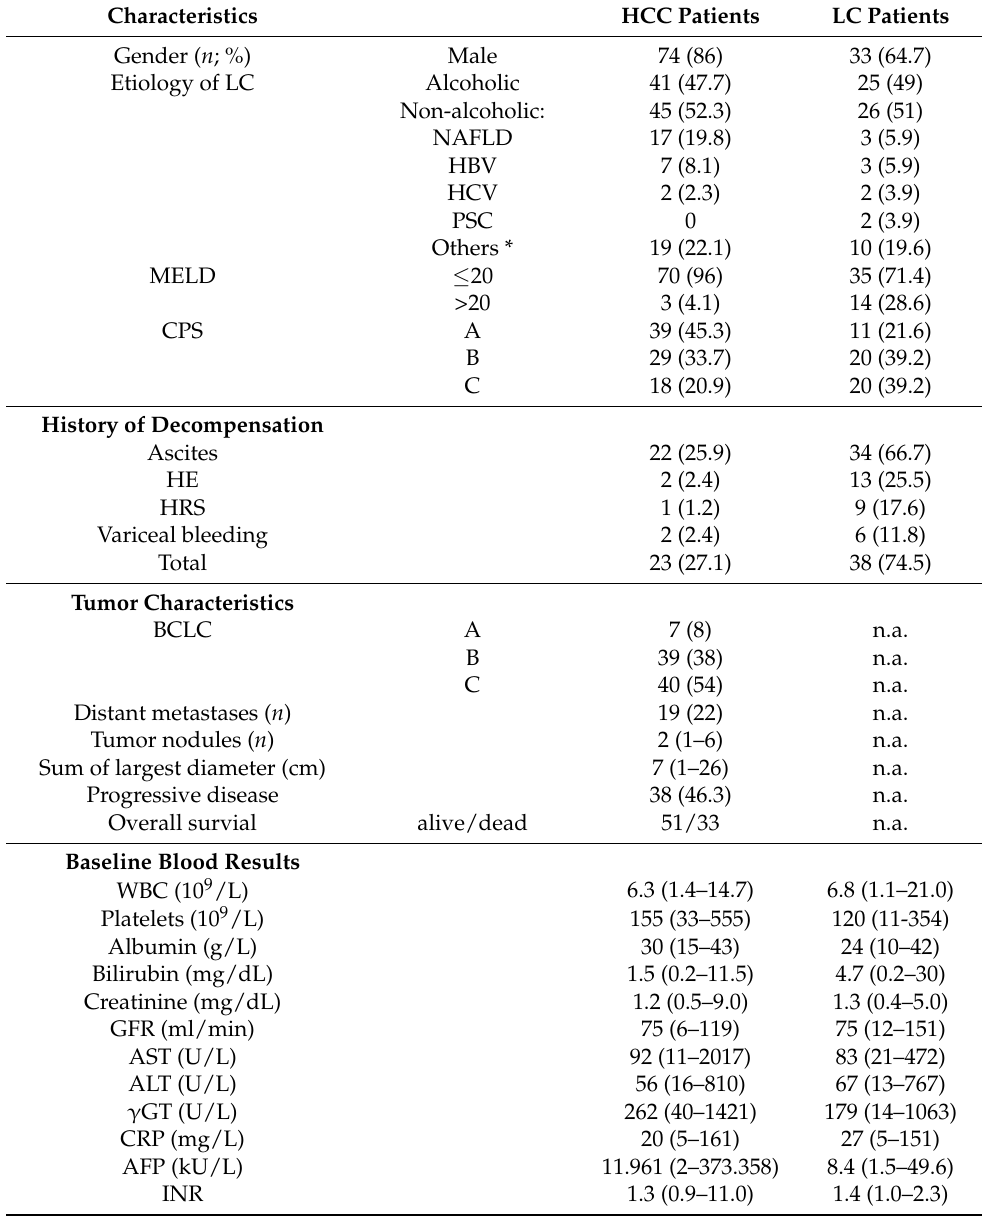
Table 2. Clinicopathological parameters of HCC and liver cirrhosis (LC) patients analyzed using single TaqMan PCR (validation cohort). This cohort included 86 HCC patients (median age: 67; range 39–86), 51 LC patients (51; 21–78) and 20 healthy individuals (40;